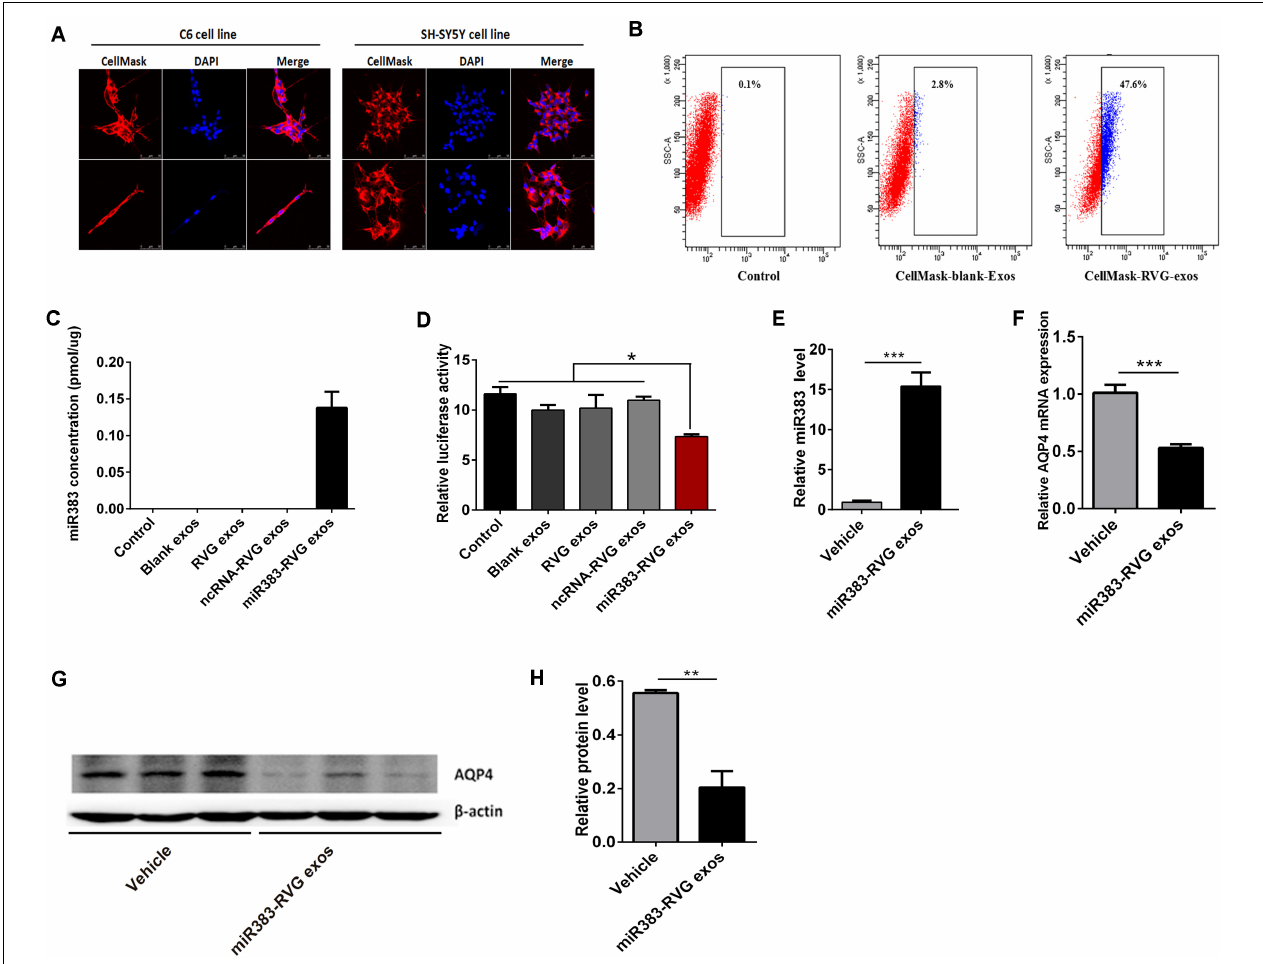
FIGURE 5 | Exosome-mediated delivery of miR-383-5p suppressed AQP4 expression in vitro and in vivo . (A) Flow cytometric analysis of RVG exosomes binding to C6 cells. Exosomes purified from HEK 293 cells were labeled with CellMask and incubated with C6 for 1 h. CellMask-labeled RVG exosomes showed significantly higher binding compared with blank exosomes. No binding was observed in the control (without the addition of exosomes). (B) Monitoring of HEK293-derived exosome uptake in vitro into C6 and SH-SY5Y cells at 8 h after exosome treatment. Exosomes were labeled with CellMask (red) and cell nuclei were stained with DAPI (blue). Scale bars = 50 µ m. (C) Absolute RT-qPCR analysis of miR-383-5p levels in various exosomes. (D) Relative luciferase activity was measured in C6 cells incubated with various exosomes after transfected with the pGL3 plasmid including the 3 (cid:48) -UTR of AQP4. (E) RT-qPCR analysis of miR383 concentration in the hippocampus of rats treated with saline and miR383 in RVG exosome. (F) RT-qPCR analysis of AQP4 mRNA levels in the hippocampus of rat treatment as described in panel (E) . (G) Western blot analysis of AQP4 protein levels in the hippocampus of rat treated as described in panel (E) . The samples derive from the same experiment and the blots were processed in parallel. (H) Quantification of the AQP4 protein levels in panel (G) . n = 6, * p < 0.05; ** p <